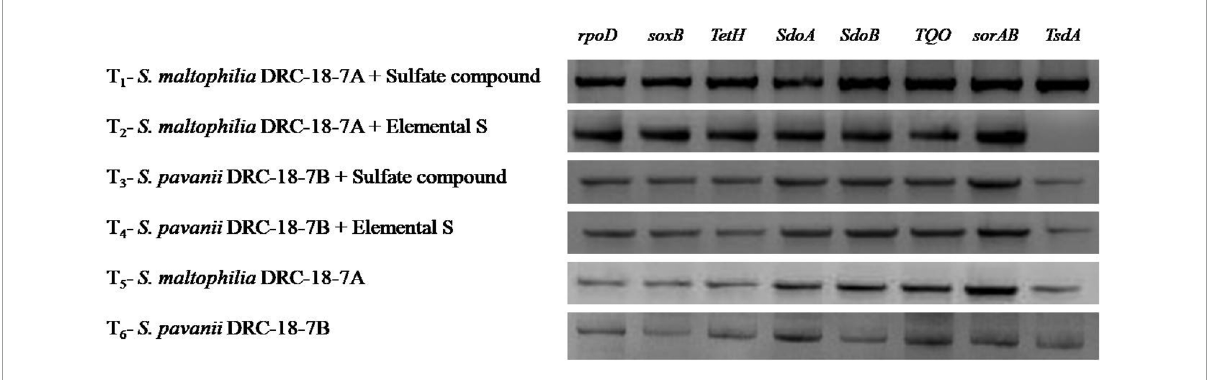
FIGURE3 Effects of different treatments on expression of genes responsible for S-oxidation in the plant rhizosphere, treatments were as follows: T 1 - Stenotrophomonas maltophilia DRC-18-7A + Sulfate compound, T 2 - S. maltophilia DRC-18-7A + Elemental S, T 3 - S. pavanii DRC-18-7B + Sulfate compound, T 4 - S. pavanii DRC-18-7B + Elemental S, T 5 - S. maltophilia DRC-18-7A, T 6 - S. pavanii